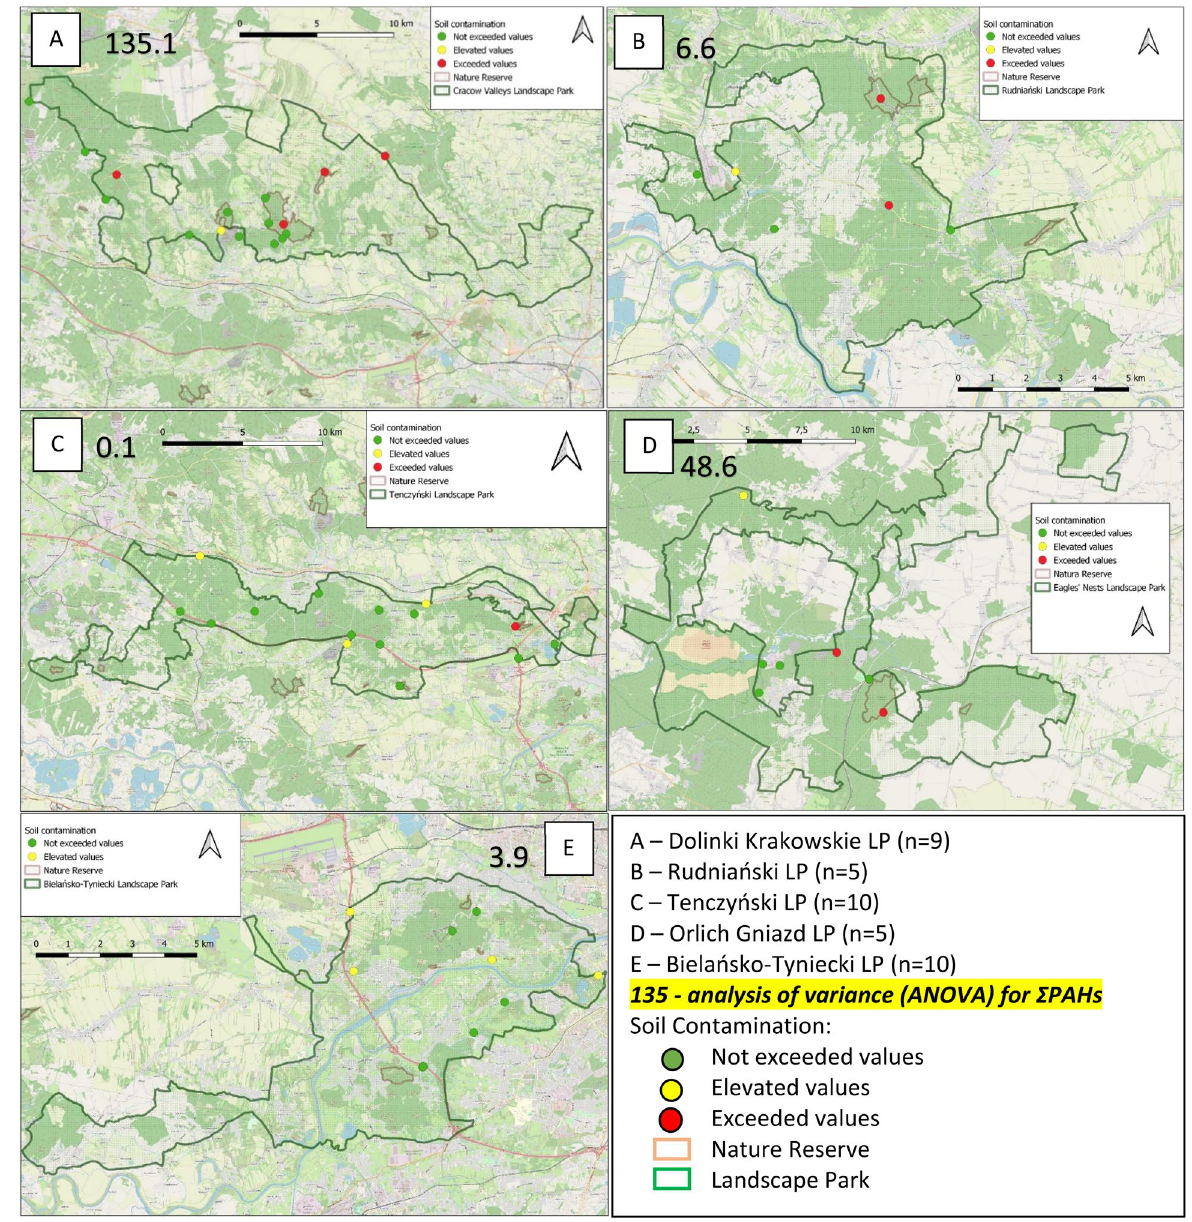
Figure 4. Soil PAH contamination on Małopolska Landscape Parks